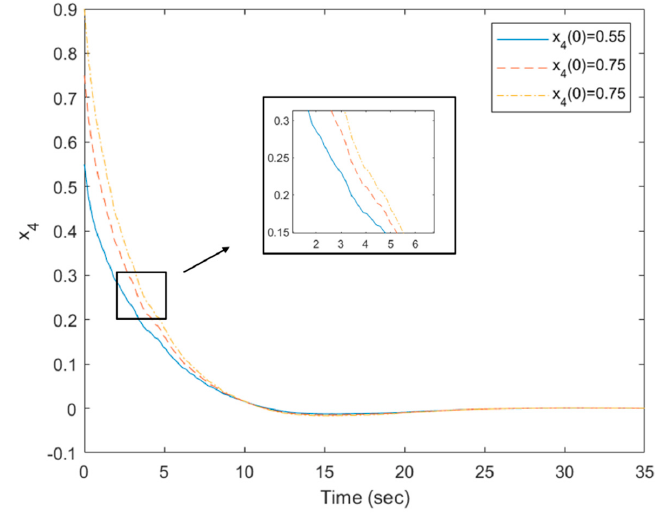
Figure 5. Response of 𝑥 (cid:2872) (cid:4666)𝑡(cid:4667) .